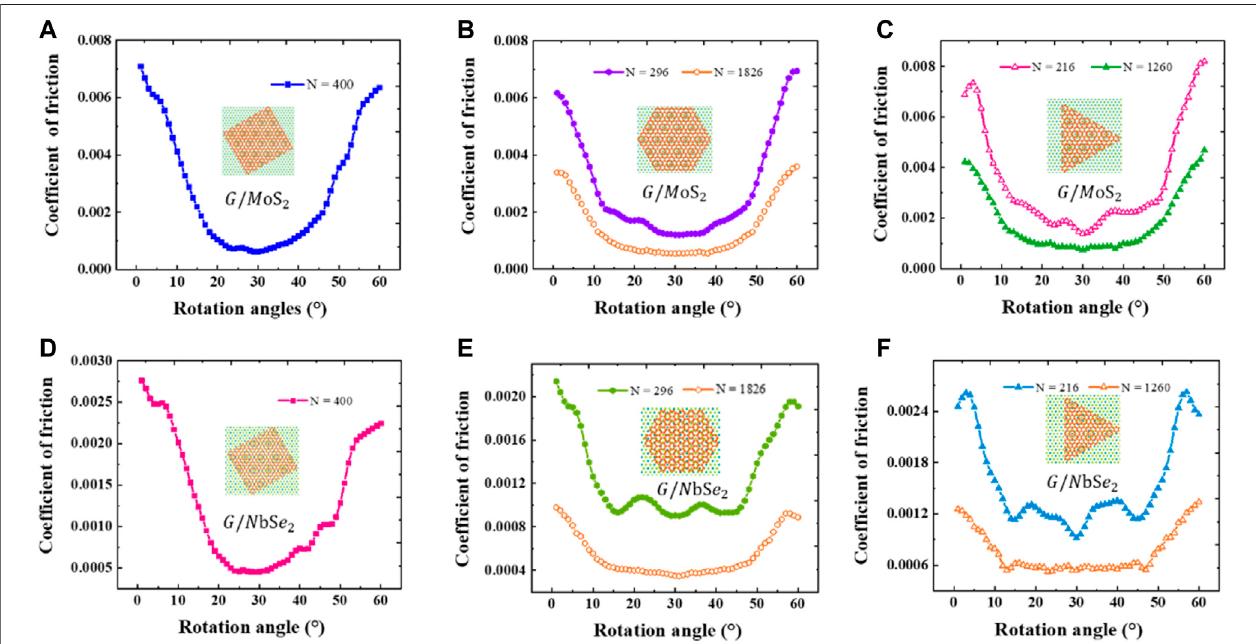
FIGURE 3 | Variation in the interlayer friction coef fi cient with rotation angle for van der Waals heterostructures of different shapes. (A – C) graphene/MoS 2 ; (D – F)